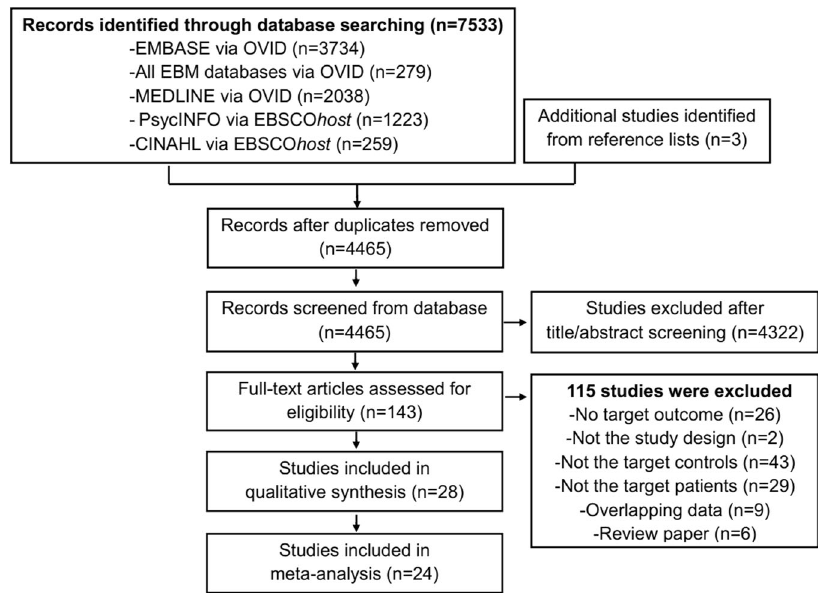
Fig. 1 Flow chart used for the identi fi cation of eligible